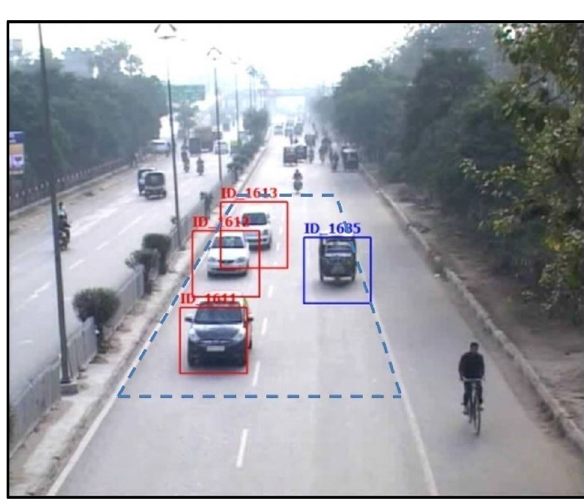
Fig. 5 Marking of vehicles in TRAZER software